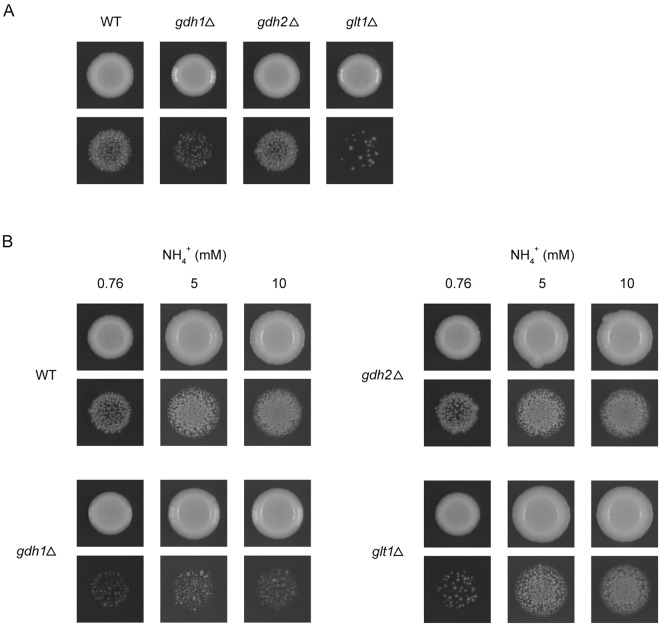
Invasive growth of gdh1Δ, gdh2Δ, and glt1Δ mutants and effect of increasing concentrations of ammonium.Invasive growth was assayed as in Fig 1. (A) HMP126 (WT), HMP135 (gdh1Δ), HMP128 (gdh2Δ), and HMP125 (glt1Δ) were grown on LNB medium. (B) HMP94 (WT), HMP137 (gdh1Δ), HMP133 (gdh2Δ), and HMP131 (glt1Δ) were grown on LNB medium and media in which 0.76 mM NH4+ in LNB was replaced by 5 or 10 mM NH4+.